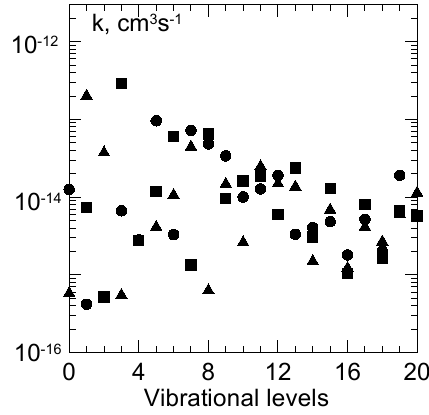
Fig. 4. The calculated rate coefficients of the excitation of the B 3 5 g state in the process (3) for vibrational levels v=0, 2, 4 of the A 3 6 + u Figure 4. The calculated rate coefficients of the excitation of the B 3 Π g state in the process (3) for state – squares, circles, triangles, respectively. vibrational levels v=0, 2, 4 of the A 3 Σ u + state – squares, cicles, triangles, respectively.